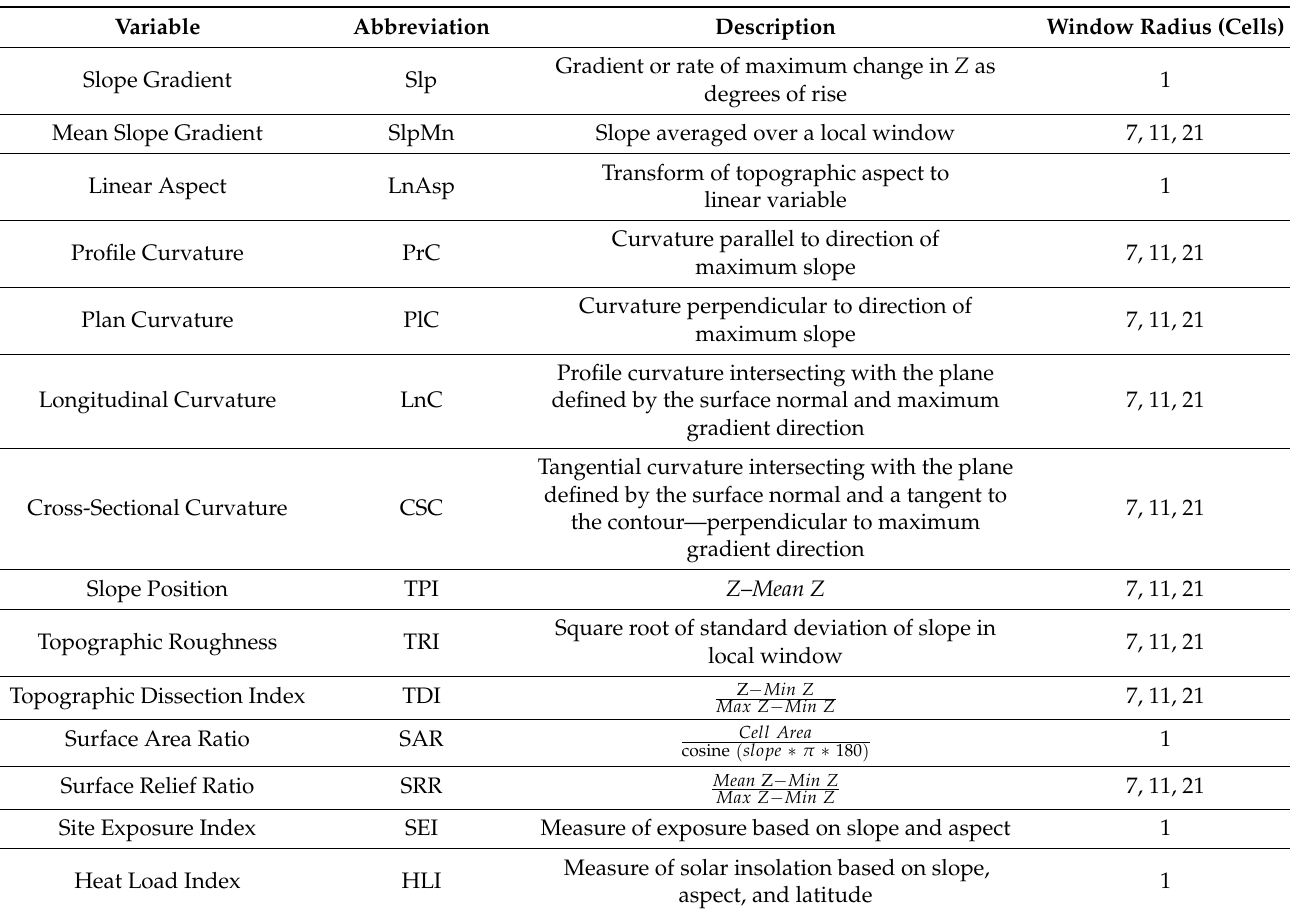
Table 2. Description of terrain variables used in this study. Abbreviations defined in this table are used throughout this